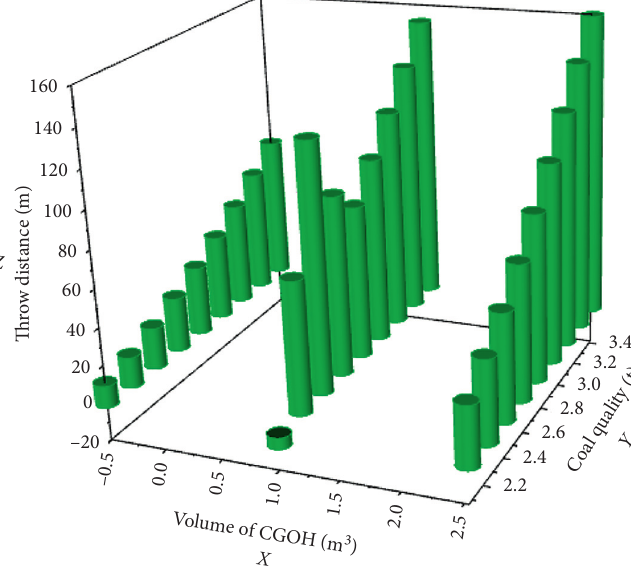
Figure 18: 3D bars of CGOH parameters ( XYZ log